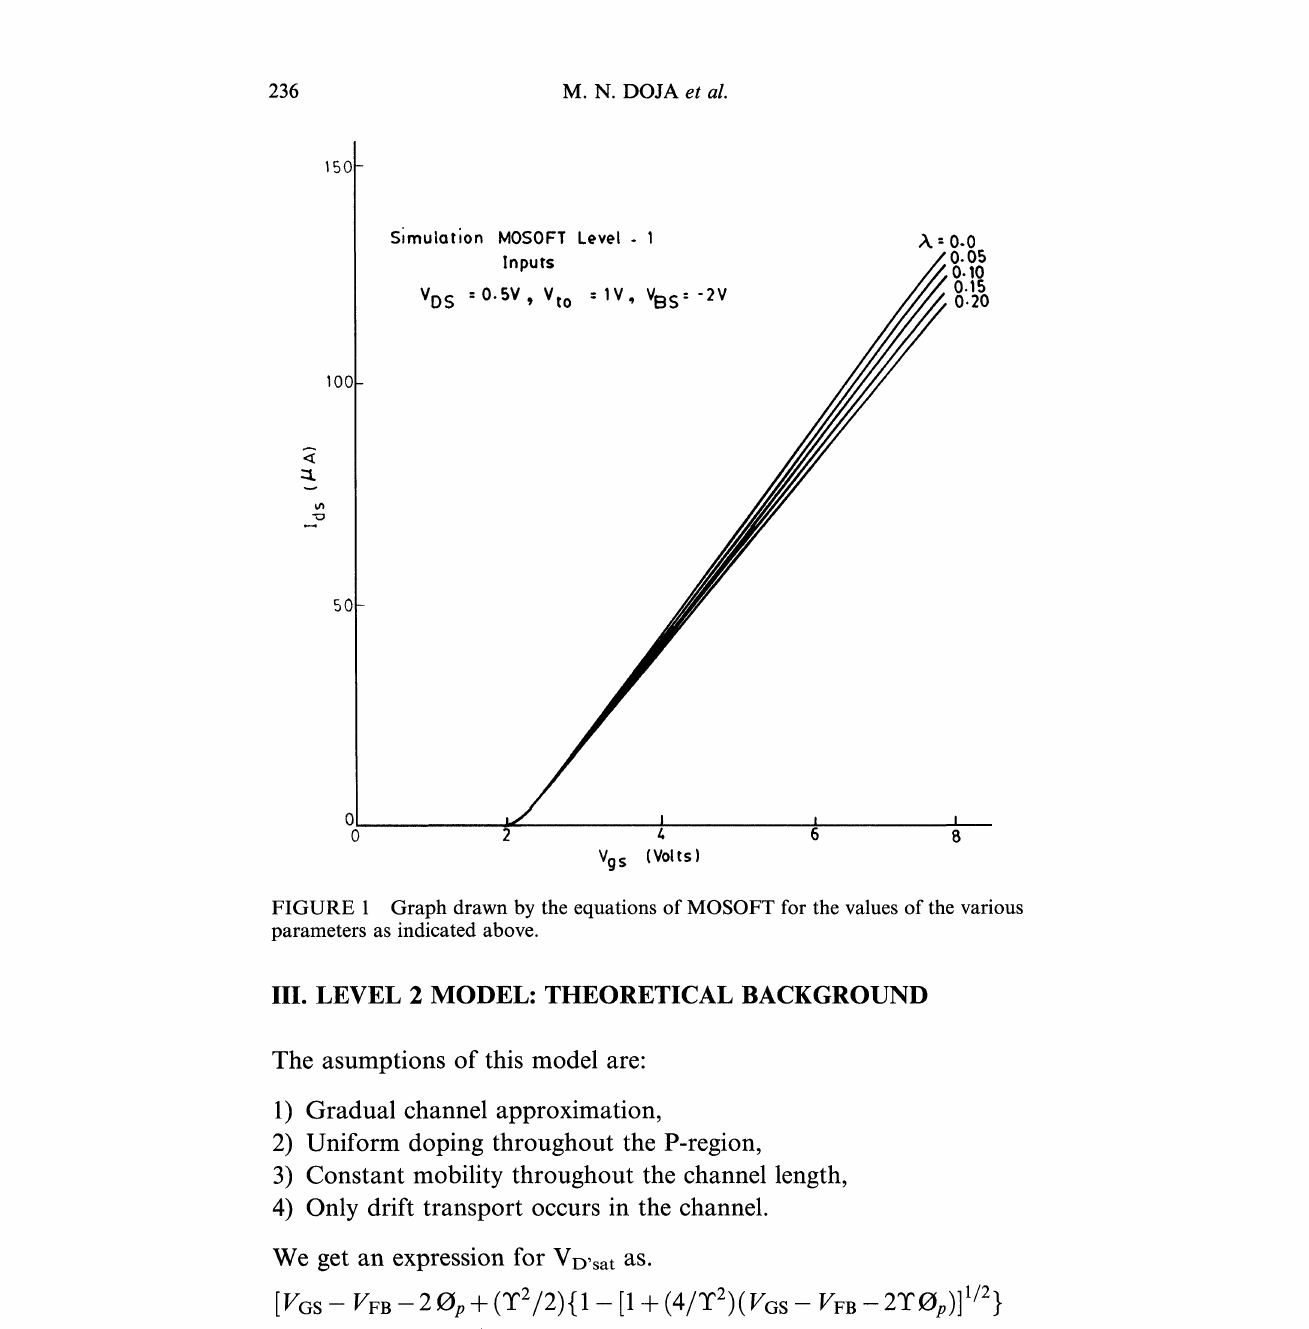
FIGURE Graph drawn by the equations of MOSOFT for the values of the various parameters as indicated